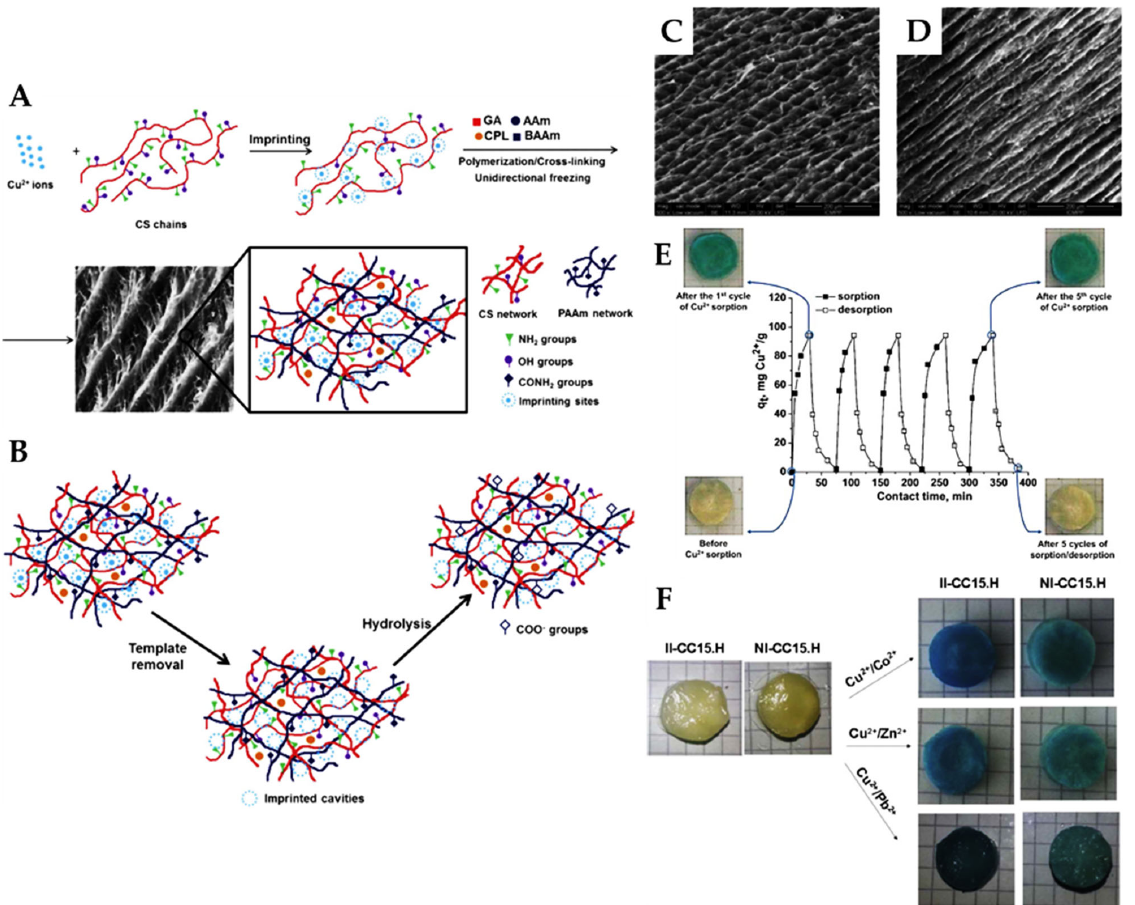
Figure 6. Preparation of Cu(II) ‐ imprinted PAAm/CS/zeolite composite cryogels ( A ) and the re ‐ moval of template Cu(II) ions and partial hydrolysis of amide groups in PAAm ( B ) (reproduced with permission from Ref. [42]. Copyright 2018 Elsevier). SEM micrographs of Cu(II) ‐ imprinted PAAm/CS/zeolite composite cryogels after the elution of Cu(II) ions recorded perpendicular ( C ) and parallel ( D ) to the direction of freezing (reproduced with permission from Ref. [42]. Copyright